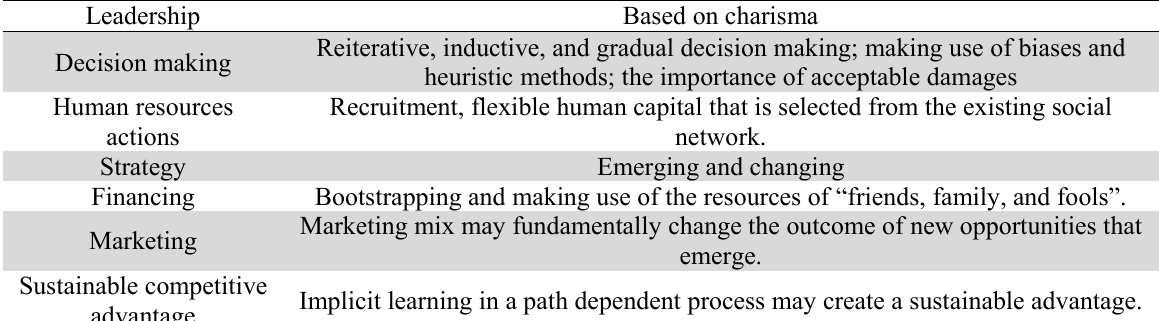
Effective entrepreneurial actions in creation context (Alvarez & Barney, 2007) Leadership Based on charisma Reiterative, inductive, and gradual decision making; making use of biases and Decision making heuristic methods; the importance of acceptable damages Human resources Recruitment, flexible human capital that is selected from the existing social actions network. Strategy Emerging and changing Financing Bootstrapping and making use of the resources of “friends, family, and fools”. Marketing mix may fundamentally change the outcome of new opportunities that Marketing emerge. Sustainable competitive Implicit learning in a path dependent process may create a sustainable advantage